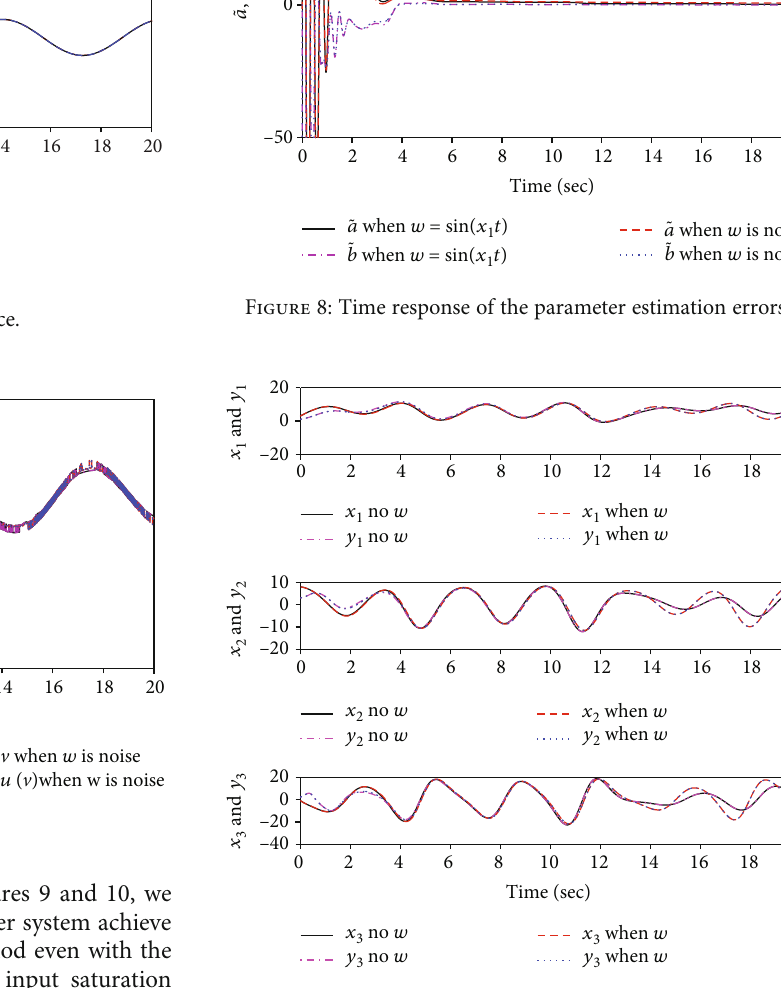
Figure 9: Synchronization of